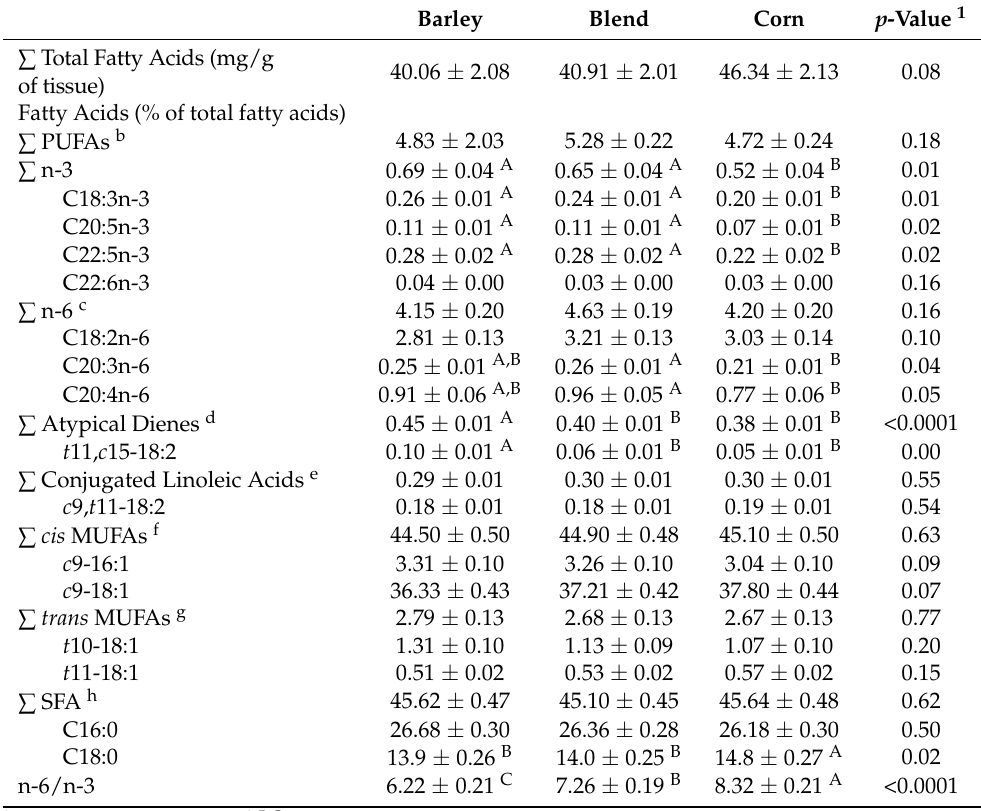
Table 2. Fatty acid composition a in longissimus thoracis samples from barley, corn, and blended grain-fed cattle. Barley Blend Corn p -Value 1 ∑ Total Fatty Acids (mg/g of